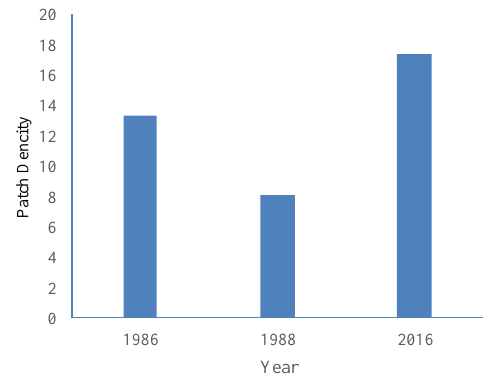
Figure 7. Changes in Patch Density (PD) in 1986, 1998 and 2016